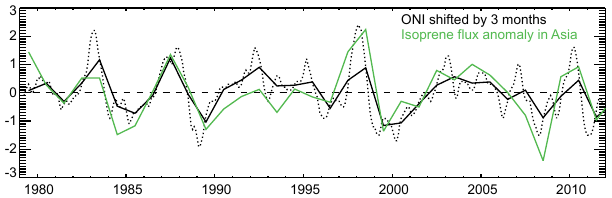
Fig. 7. Isoprene flux anomaly in Asia (green) and comparison with the Oceanic Niño Index (black) shifted by 3 months over the tar- get period. Dotted and solid black lines correspond to monthly and annual ONI data,